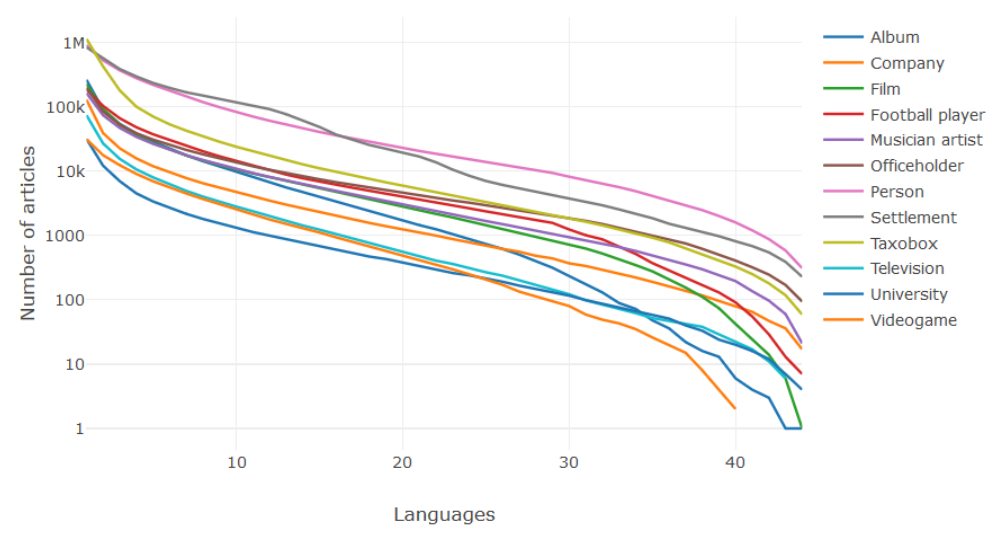
Figure 3. Number of articles that have a certain number of language versions in particular topics. Source: own calculations.